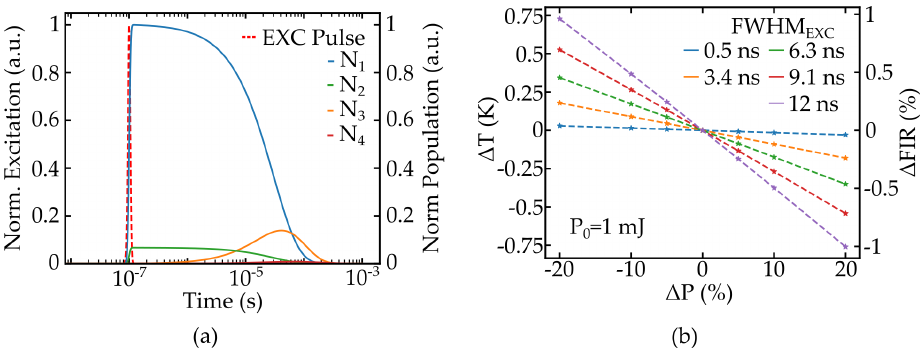
Figure 4. Temporal evolution of population density calculated for approximated Pr 3 + ( a ) and the resulting temperature error ∆ T for FIR measurements depending on pump energy fluctuations ∆ P in ( b ).